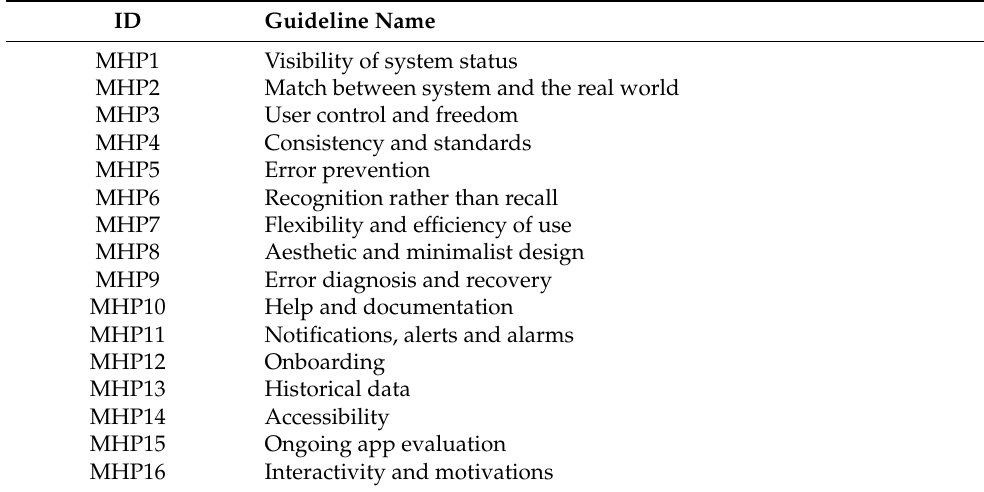
Table 7. The set of proposed usability guidelines for mHealth applications